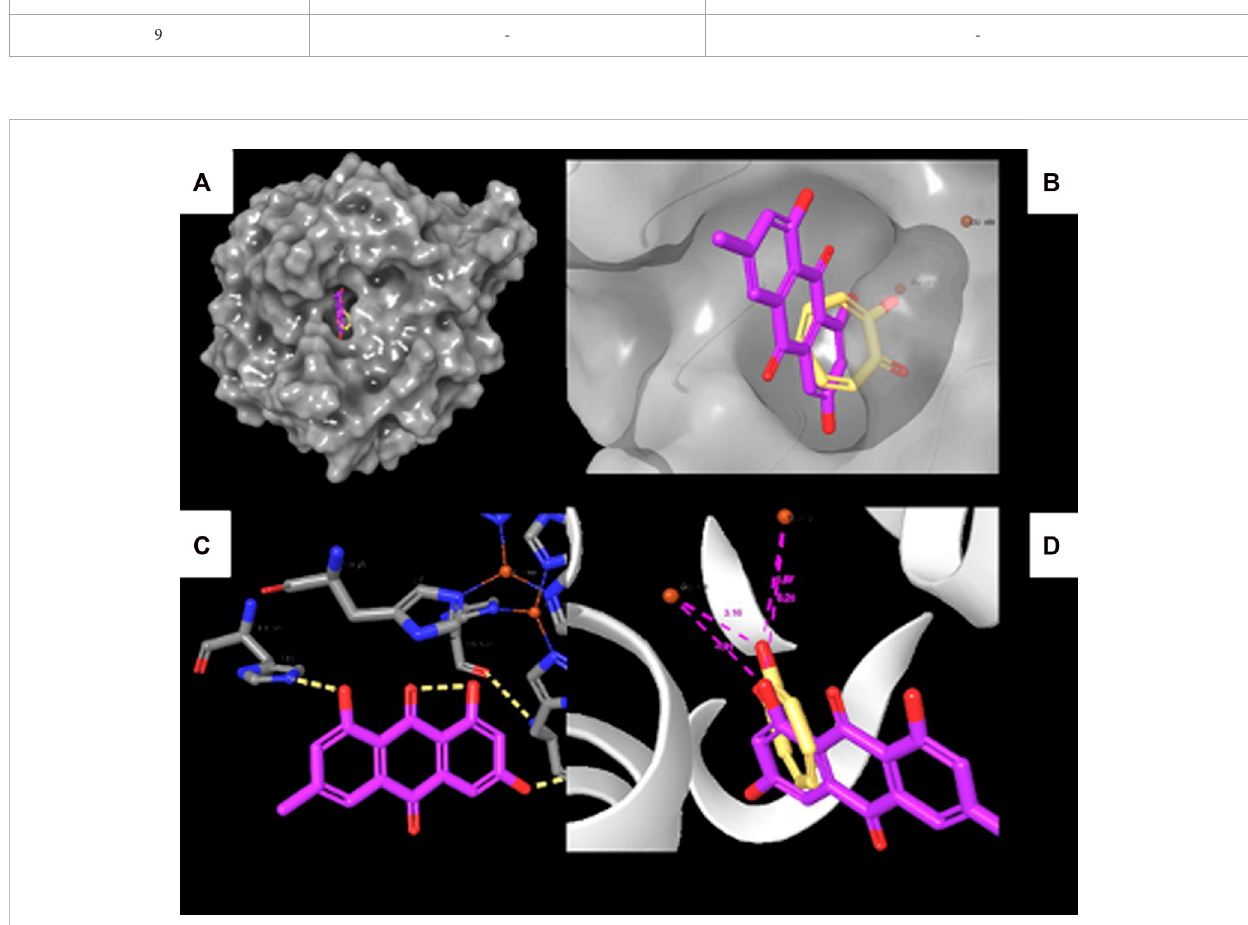
FIGURE 7 MoleculardockinginteractionsofMetabolite5withthetyrosinasecrystalstructure. (A) SurfacerepresentationoftyrosinasewithMetabolite5(violet) and tropolone (yellow) at the active site. (B) Active site of tyrosinase with Metabolite 5 (violet) and tropolone (yellow) with two copper ions. (C) Molecular interactions between Metabolite 5 and amino acid residues (dotted yellow lines represent hydrogen bonds). (D) Measured distance between two copper ions and oxygen atoms in Metabolite 5 and tropolone chemical